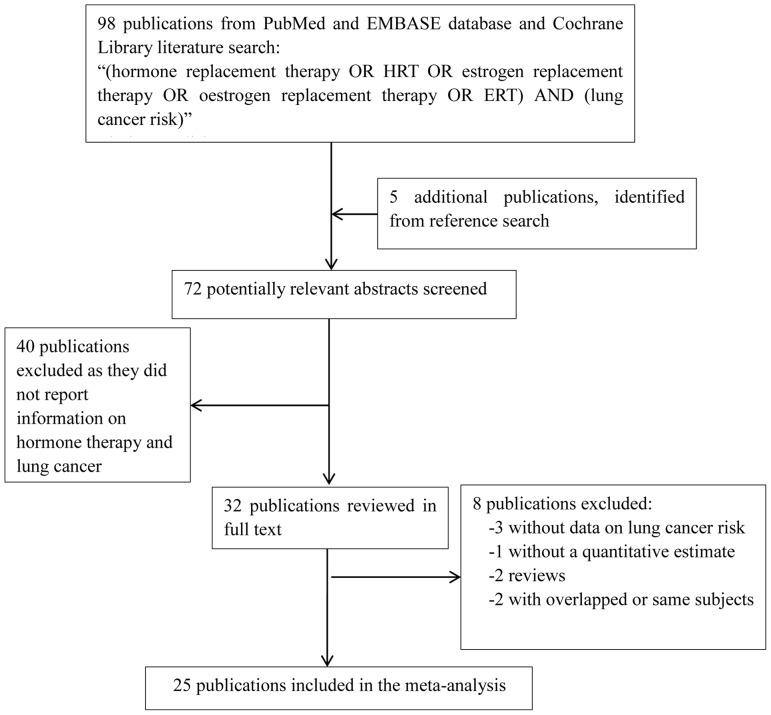
Flowchart of study identifying and including studies.